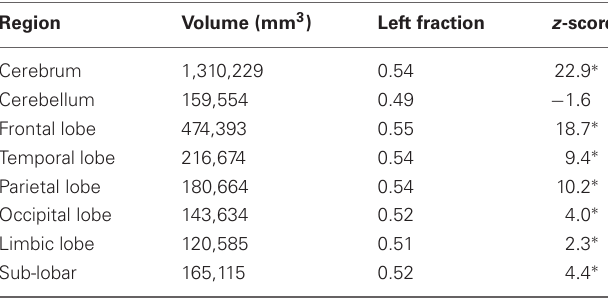
Table 2 | Left-Right distribution of activation foci by brain